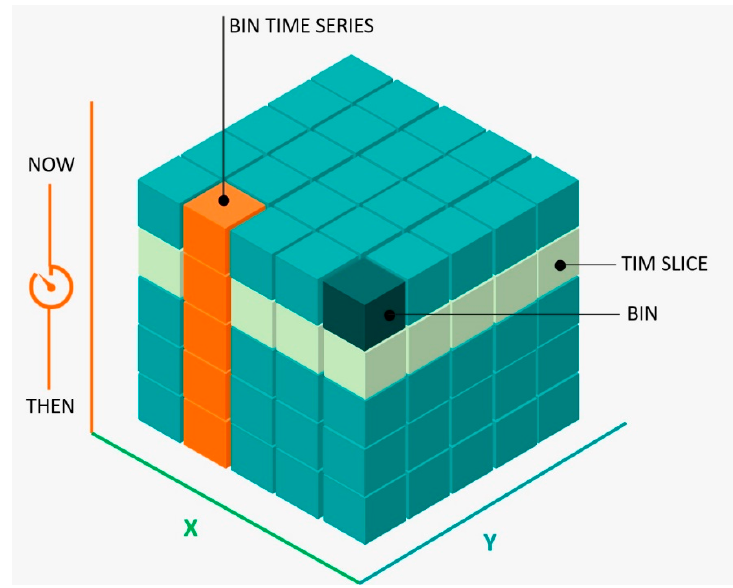
Figure A2. Visualization 3D of STC. Based on [71], modified.